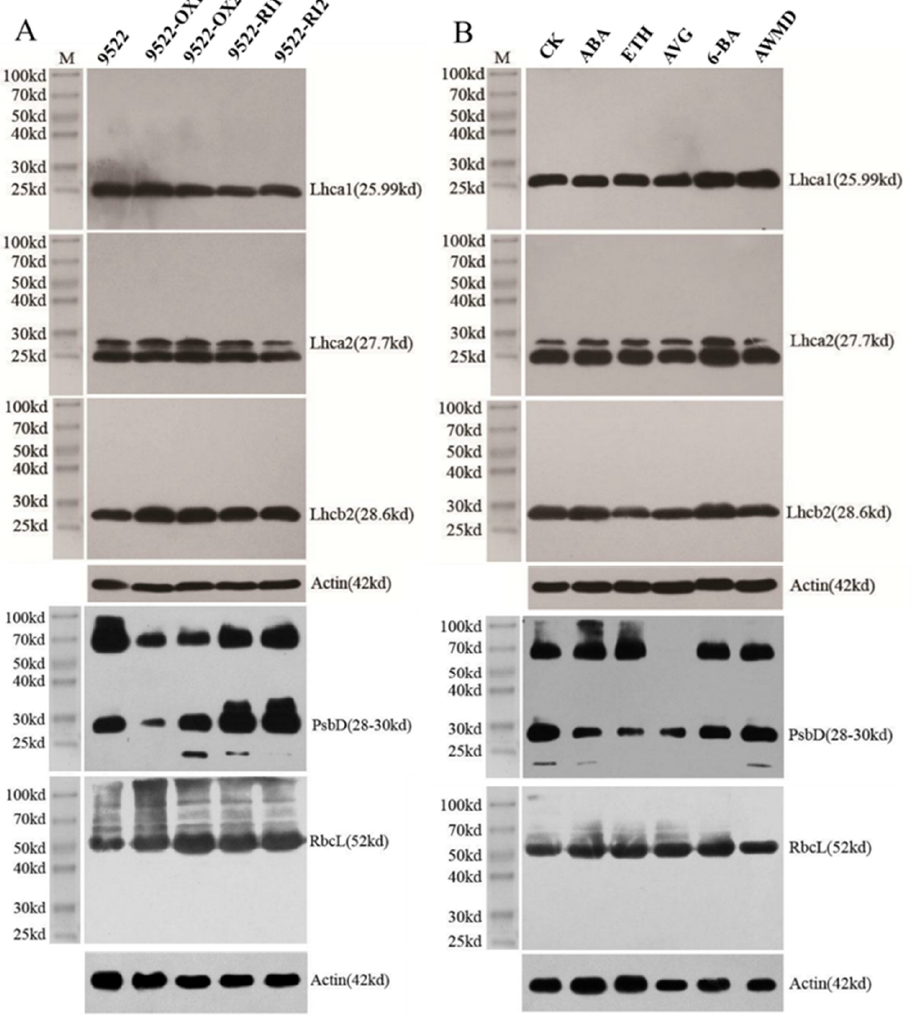
Figure 5. Western blot analysis of photosynthetic proteins from leaves of wildtype and transgenic lines at heading stage ( A ), and 15 days after the application of exogenous phytohormone/alternate wetting and under moderate drying (AWMD) irrigation ( B ). Lhca1, Lhca2 are light-harvesting complex I (LHCI) apoproteins. Lhcb2 is an LHCII apoprotein. PsbD is the D2 reaction center polypeptide of photosystem II. RbcL is the large subunit of Rubisco. Symbols are as described in Figure 1.